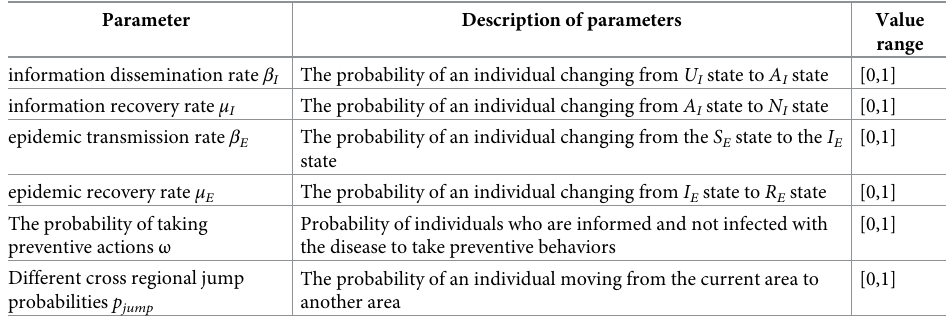
Table 1. Model parameter